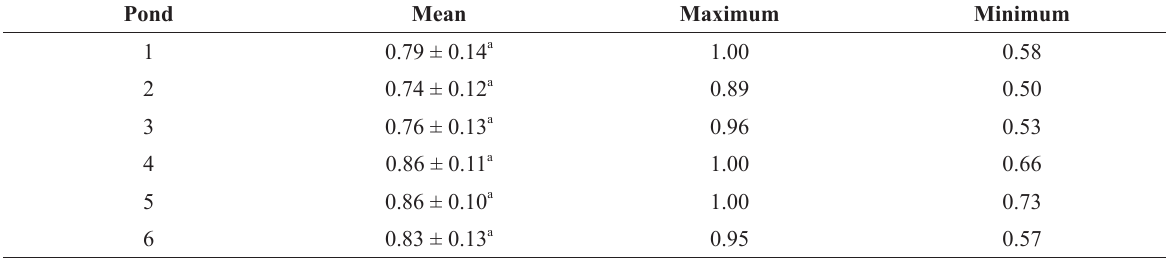
Means (± SD) of technical efficiency of the conventional system ponds in a farm located on the coast of Pernambuco, Brazil, obtained through data envelopment analysis with constant returns to scale.